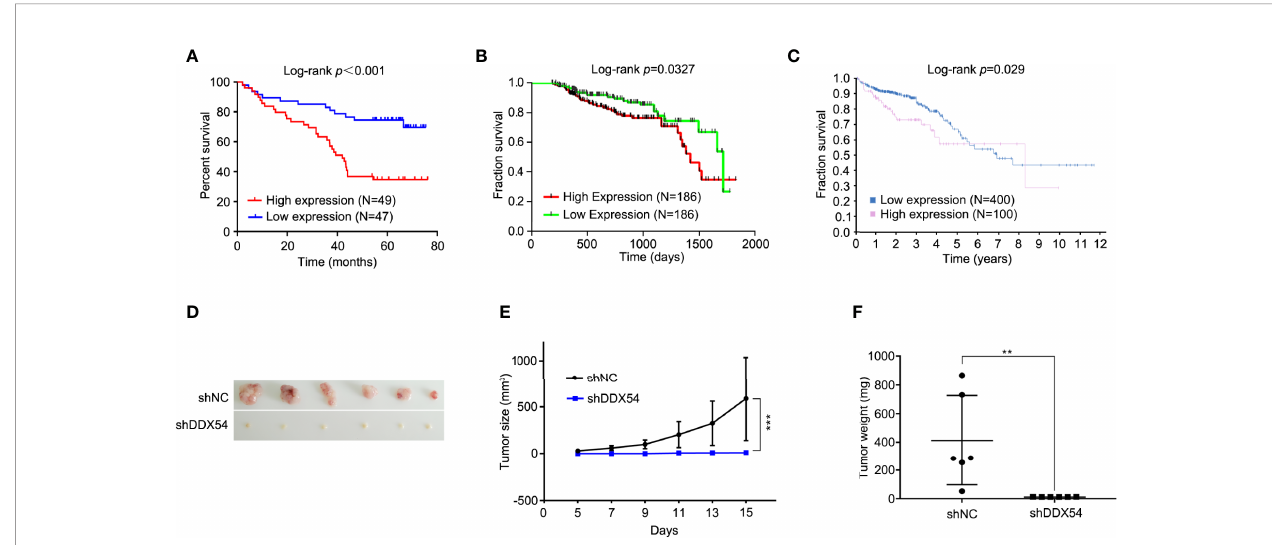
FIGURE 3 | DDX54 expression and signi fi cance in colorectal cancer was analyzed in TCGA database. (A) The relation between DDX54 mRNA level and CRC survival time was analyzed of tissue microarray. (B) Kaplan-Meier plots of the overall survival of patients strati fi ed by DDX54 expression were analyzed on CRC patients from TCGA database with the less than 5-followup period. (C) The relation between DDX54 mRNA level and survival was analyzed on CRC patients from the Human Protein Atlas. FPKM, Fragments Per Kilobase per Million. (D) The representative images for subcutaneous tumors of DDX54 knockdown mice and relative controls. (E) The size of subcutaneous tumors was calculated at different times, ***P < 0.001. (F) The tumor weights of mice with control or DDX54 knockdown injection were counted, **P < 0.01.